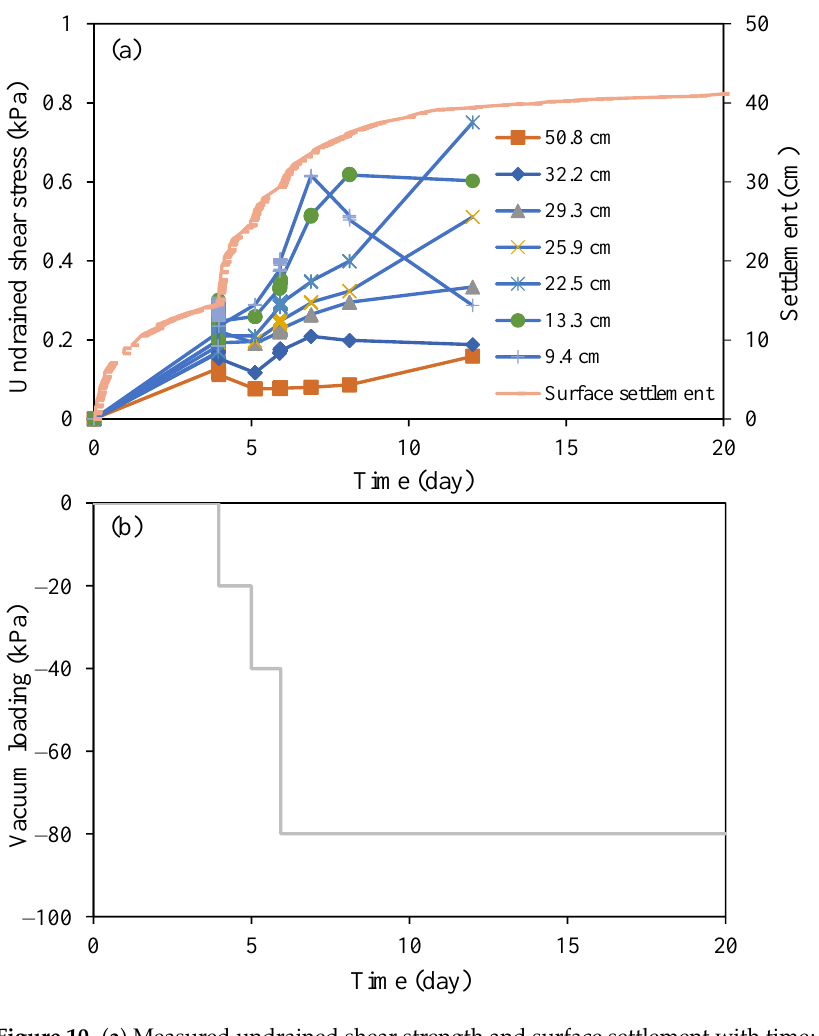
Figure 10. ( a ) Measured undrained shear strength and surface settlement with time; and ( b ) vacuum loading with time. After the test, the vane shear test was conducted to measure the undrained shear strength of the soil for comparison. Figure 11a shows the undrained shear strength pro- files measured by the OFDR coin sensor and the vane shear test at different times. It can be seen that values of undrained shear strength obtained from the vane shear test after Day 20 were larger than those measured by the OFDR coin sensor at Day 12. This could